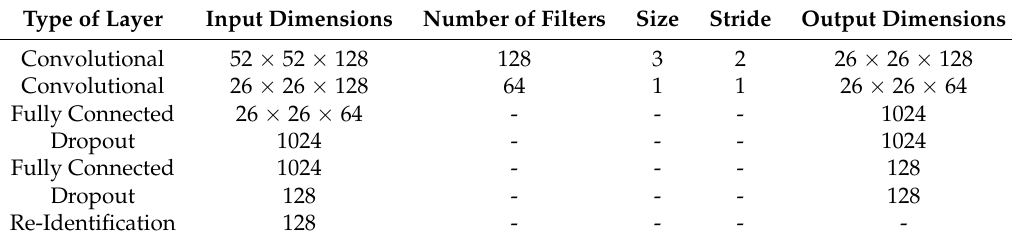
Table 2. Proposed Network Architecture—layers added in the second phase of training.